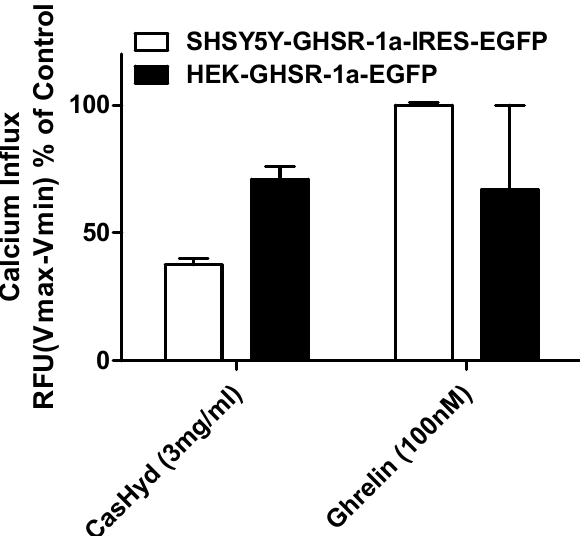
Figure 4. Specific activation of GHS-R1a receptor in vitro. Both CasHyd (3 mg/mL) and ghrelin (100 nM) elicited a GHS-R1a-eGFP (enhanced green fluorescent protein) mediated calcium influx in both HEK cells stably expressing GHSR1a-eGFP, and the neuronal-like SHSY-5Y cell line generated to express GHSR1a-eGFP using lentiviral vectors. Graph represents the mean ± SEM of a representative experiment. Each concentration was carried out in triplicate. Intracellular calcium increase was normalised to maximal calcium increase as elicited by control (100 nM ghrelin).